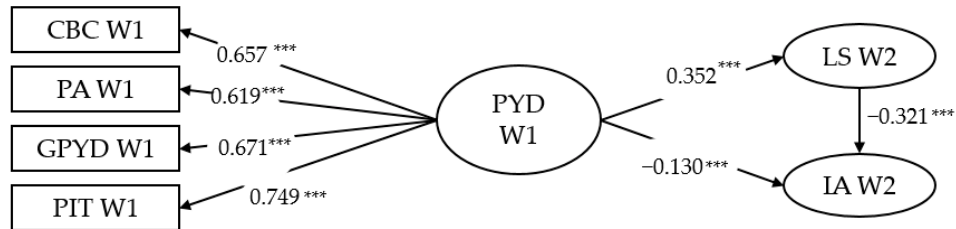
Figure 1. Standardized results of structural equation modeling (SEM) analysis on the relationships among PYD attributes, life satisfaction and Internet addiction. CBC = cognitive-behavioral compe- tence; PA = prosocial attribute; GPYD = general positive youth development; PIT = positive identity; LS = life satisfaction; IA = Internet addiction. W1 = Wave 1; W2 = Wave 2. *** p < 0.001.